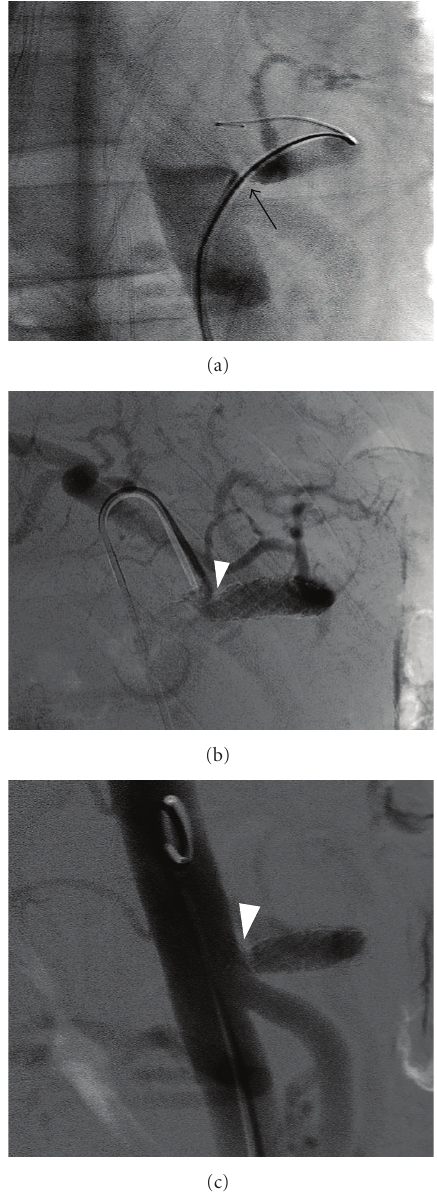
Figure 3: Celiac angiography of MALS (a) shows severe stenosis (arrow) with poststenotic dilation of celiac axis. Celiac angiography (b) and aortography (c) after balloon angioplasty with stenting show acceptable residual stenosis at proximal celiac artery (arrow- head).